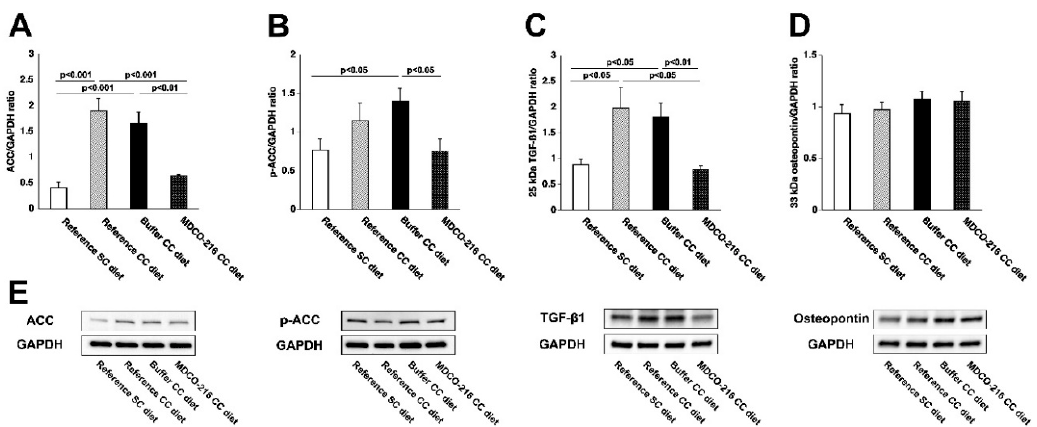
Figure 8. Quantification of proteins in the myocardium by western blot. Bar graphs illustrating ACC ( A ), p-ACC ( B ), TGF- β 1 ( C ), and osteopontin ( D ) protein levels quantified by western blot in the myocardium. SC diet mice and CC diet mice are indicated by open bars and closed bars, respectively. Representative images of western blots are shown in panel E. All protein levels were normalized to the glyceraldehyde-3-phosphate dehydrogenase (GAPDH) protein level. All data represent means ± SEM ( n = 6).